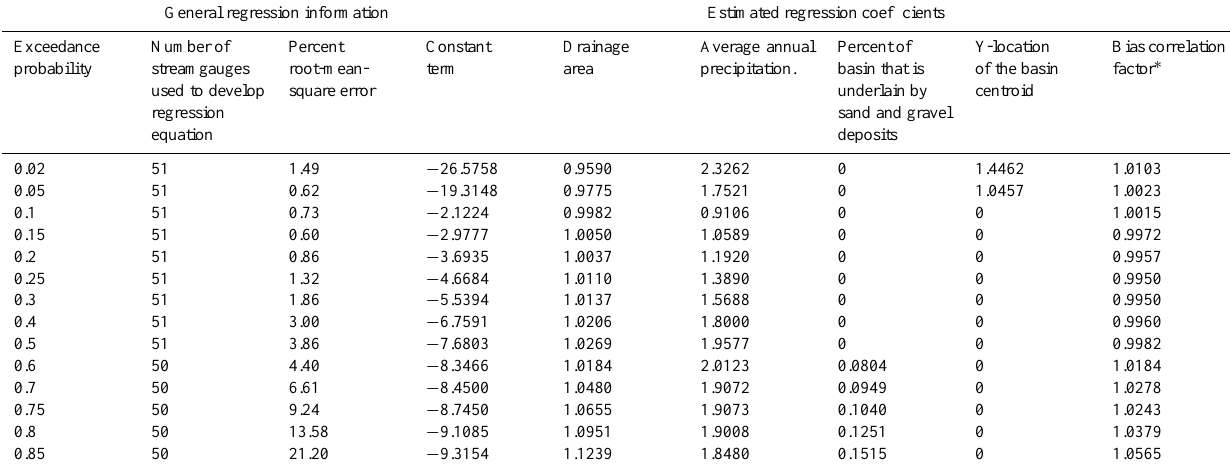
Table 2. Number of streamgauges, goodness of fit values, explanatory variables, and estimated regression parameters for streamflow quantiles estimated from catchment characteristics using multiple least squares regression ( ∗ Bias correction factor computed from Duan,